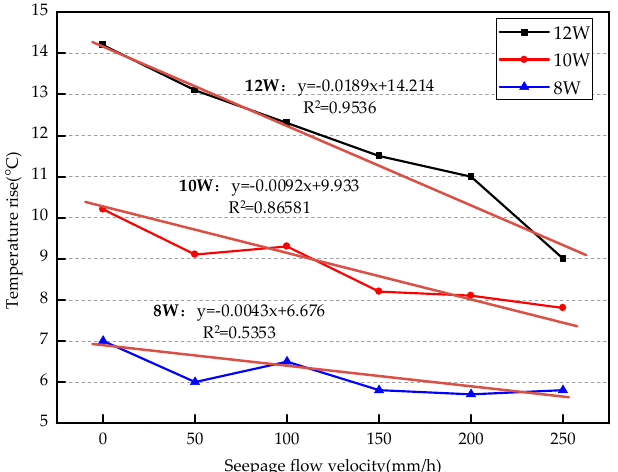
Figure 17. Relationship between temperature rise and seepage velocity.